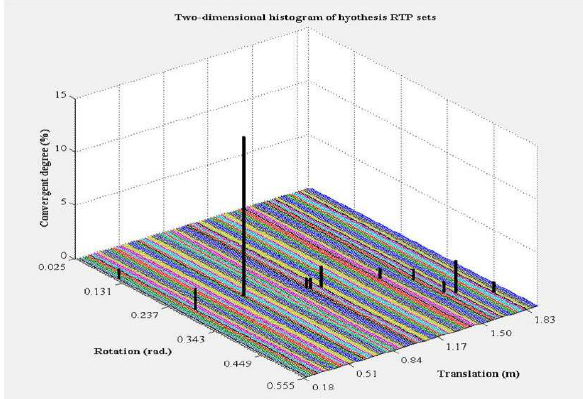
Figure 1 2D histogram of parameter sets corresponding to different hypothesis